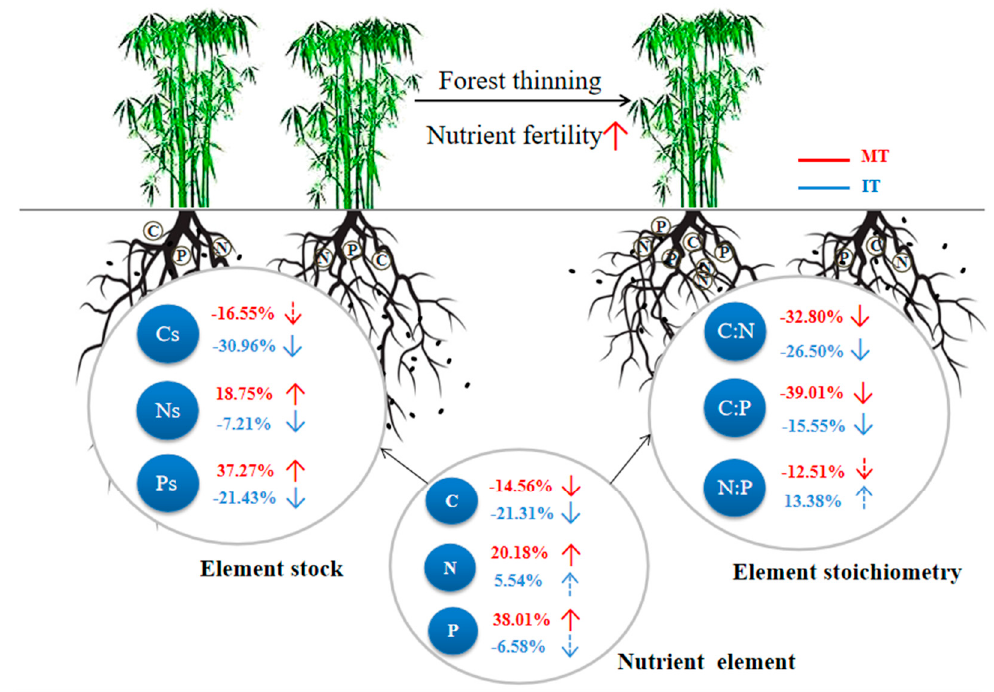
Figure 7. A conceptual diagram showing the effects of thinning on soil element contents, stocks, and their stoichiometry in a Chinese Phyllostachys edulis forest. Abbreviations: C, soil organic carbon; N, total nitrogen; P, total phosphorus; Cs, soil organic carbon stocks; Ns, total nitrogen stocks; Ps, total phosphorus stocks; C:N, SOC–to–TN ratio; C:P, SOC–to–TP ratio; N:P, soil TN–to–TP ratio. The red and blue lines represent the influencing pathways of moderate thinning (MT) and heavy thinning (IT) on soil C, N, and P contents, stocks, and their stoichiometry, respectively. The percentage values and the solid or dashed arrows beside them indicate the ratio of significant ( p < 0.05) and nonsignificant differences in the 0–30 cm soil layer compared to the control, respectively. Downward and upward arrows represent negative and positive effects, respectively.